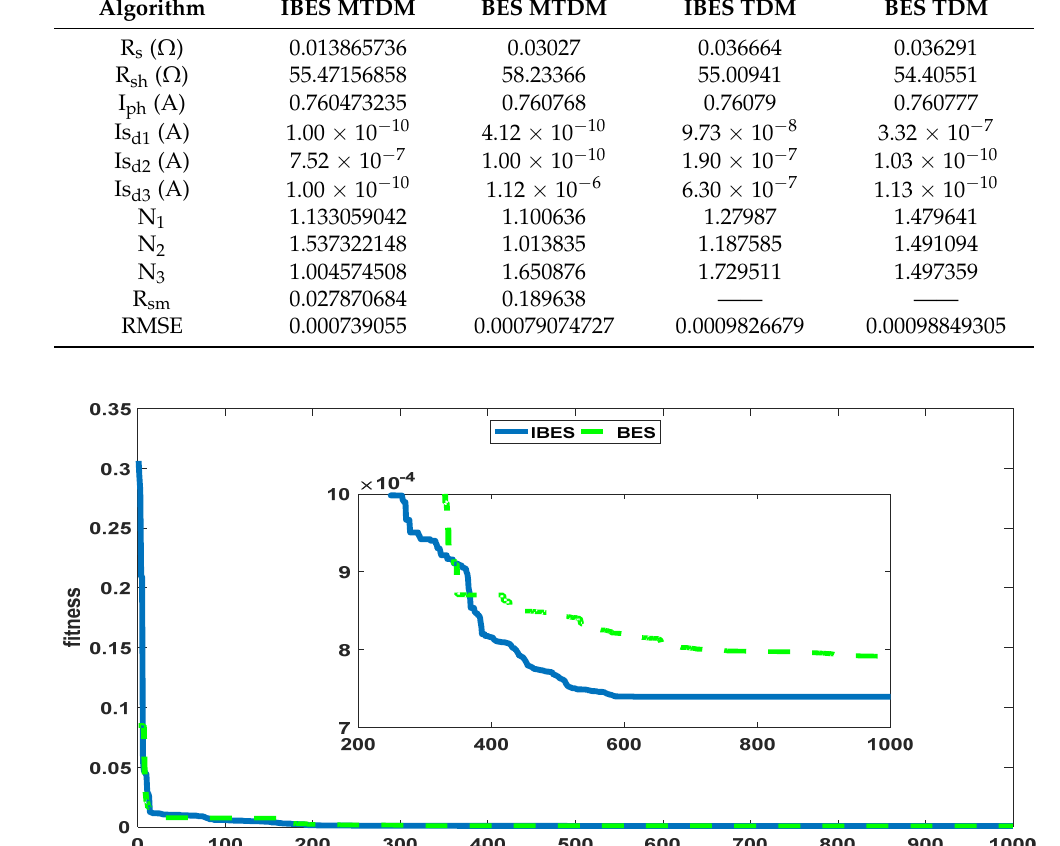
Figure 13. The convergence curves for the IBES and BES for the MTDM.